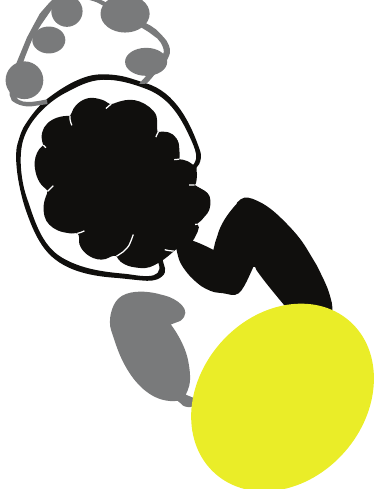
Figure 4: Schematic representation of the anatomic structures: Moderate hydroureteronephrosis (black) of left crossed fused ectopic kidney; atretic dilated right ureter (gray), and noncommuni- cating cysts in multicystic dysplastic right kidney (gray) and urinary bladder